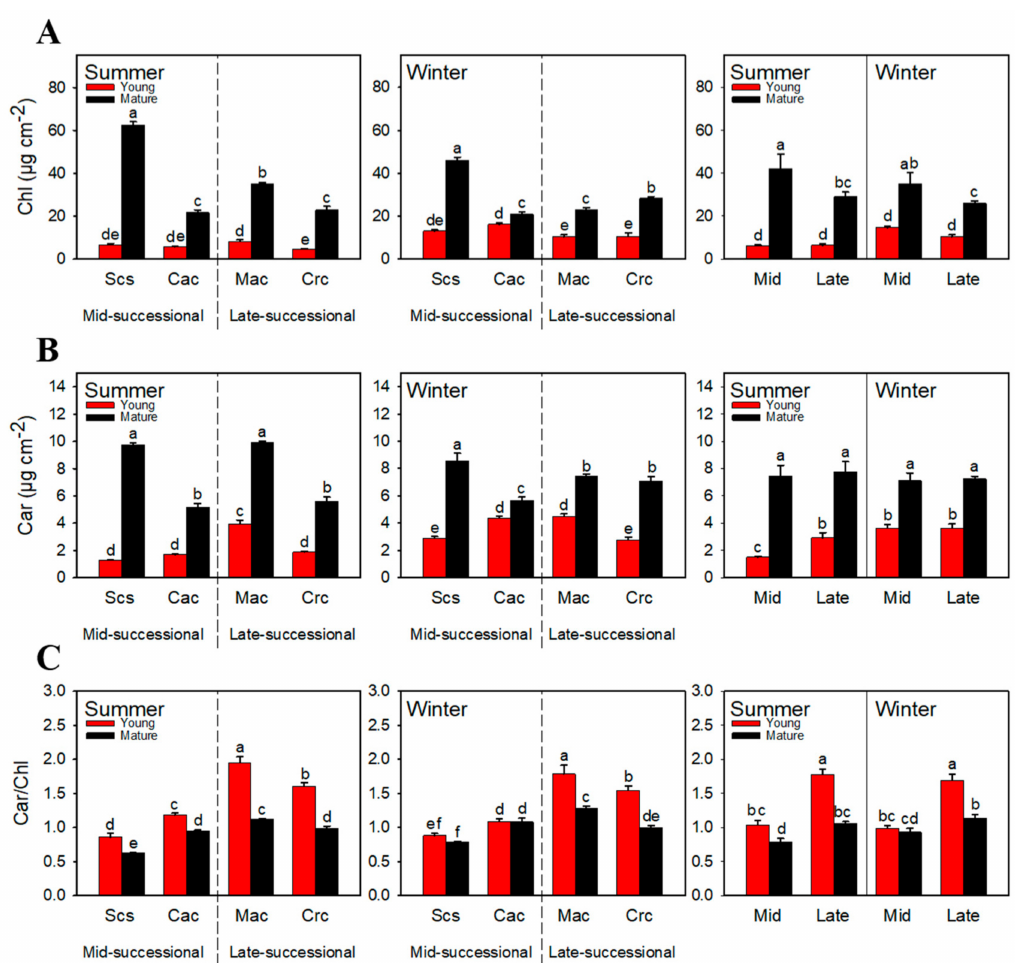
Figure 3. Total chlorophyll ( A ), carotenoids ( B ), and Car/Chl ( C ) of dominant species at different successional stages in different seasons. Scs, Schima superba ; Cac, Castanopsis chinensis ; Mac, Machilus chinensis ; Crc, Cryptocarya chinensis ; Mid, mid-successional tree group; Late, late-successional species tree group; Chl, total chlorophyll; Car, carotenoids. Different letters above bars indicate statistical significance ( p <